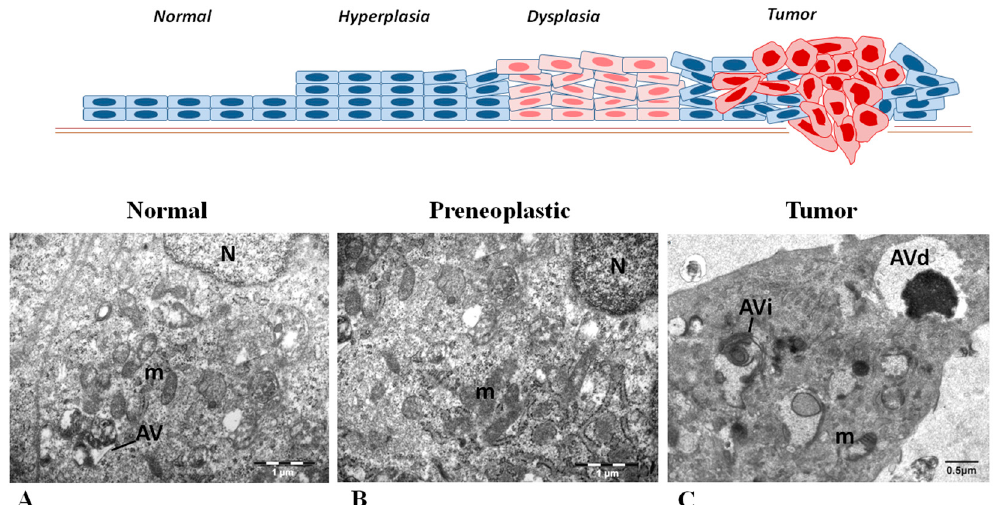
Figure 7. Representative electron micrographs of normal epithelial ( A ), preneoplastic ( B ) and tumor ( C ) laryngeal cells from the same patient. In normal laryngeal epithelium, few autophagic vacuoles (AV) were observed ( A ). In preneoplastic (dysplastic) lesions the autophagic vacuoles were rarely present ( B ). In contrast, tumor cells exhibited increased numbers of autophagic vacuoles that were either initial (AVi) or degradative (AVd) ones ( C ). Quantitative analysis of autophagic vacuoles showed the following values: 4.8 ± 0.5 in normal cells, 1.3 ± 0.6 in preneoplastic cells and 12.4 ± 0.8 in cancer cells. m, mitochondrion; N, nucleus. Scale Bars: A and B: 1 μ m; C: 0.5 μ m.